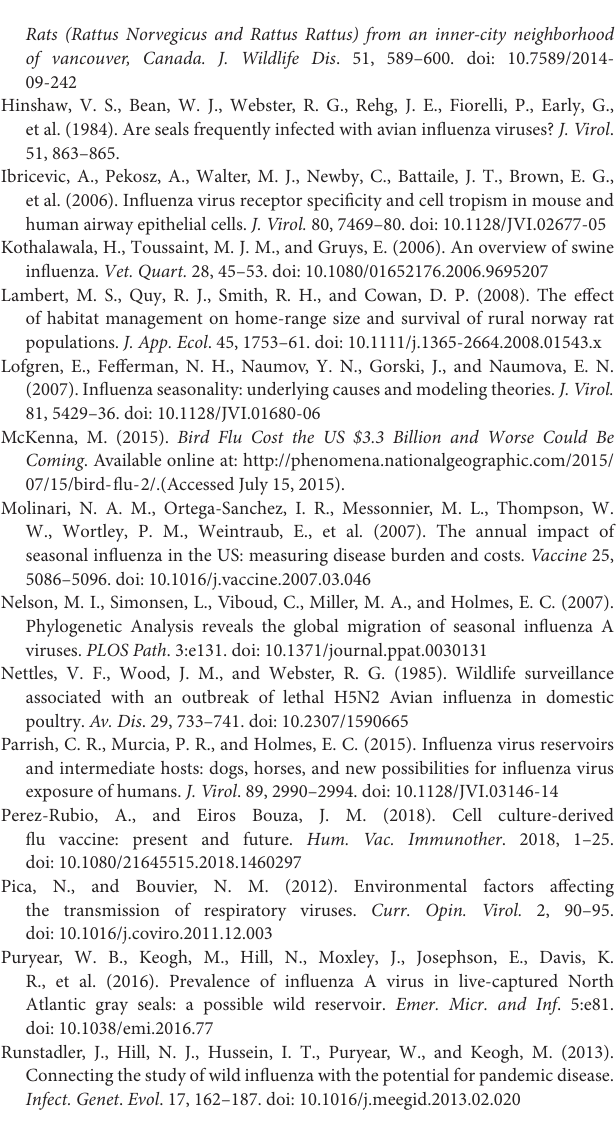
Table S1 | The distribution of predictor/dependent variables tested with Generalized Linear Models: infection status, geocluster, sex and weight, throughout the course of the study (2016–2018). Table S2 | The odds ratios associated with prevalence for each predictor variable tested with Generalized Linear Models: month, geocluster, sex and